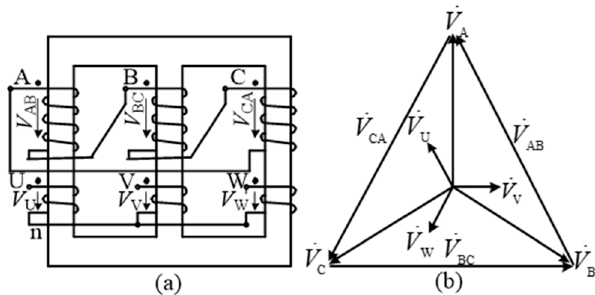
Figure 2. Vector relation of transformer. ( a ) Winding of transformer; ( b ) Vector relation of primary voltage and secondary voltage.